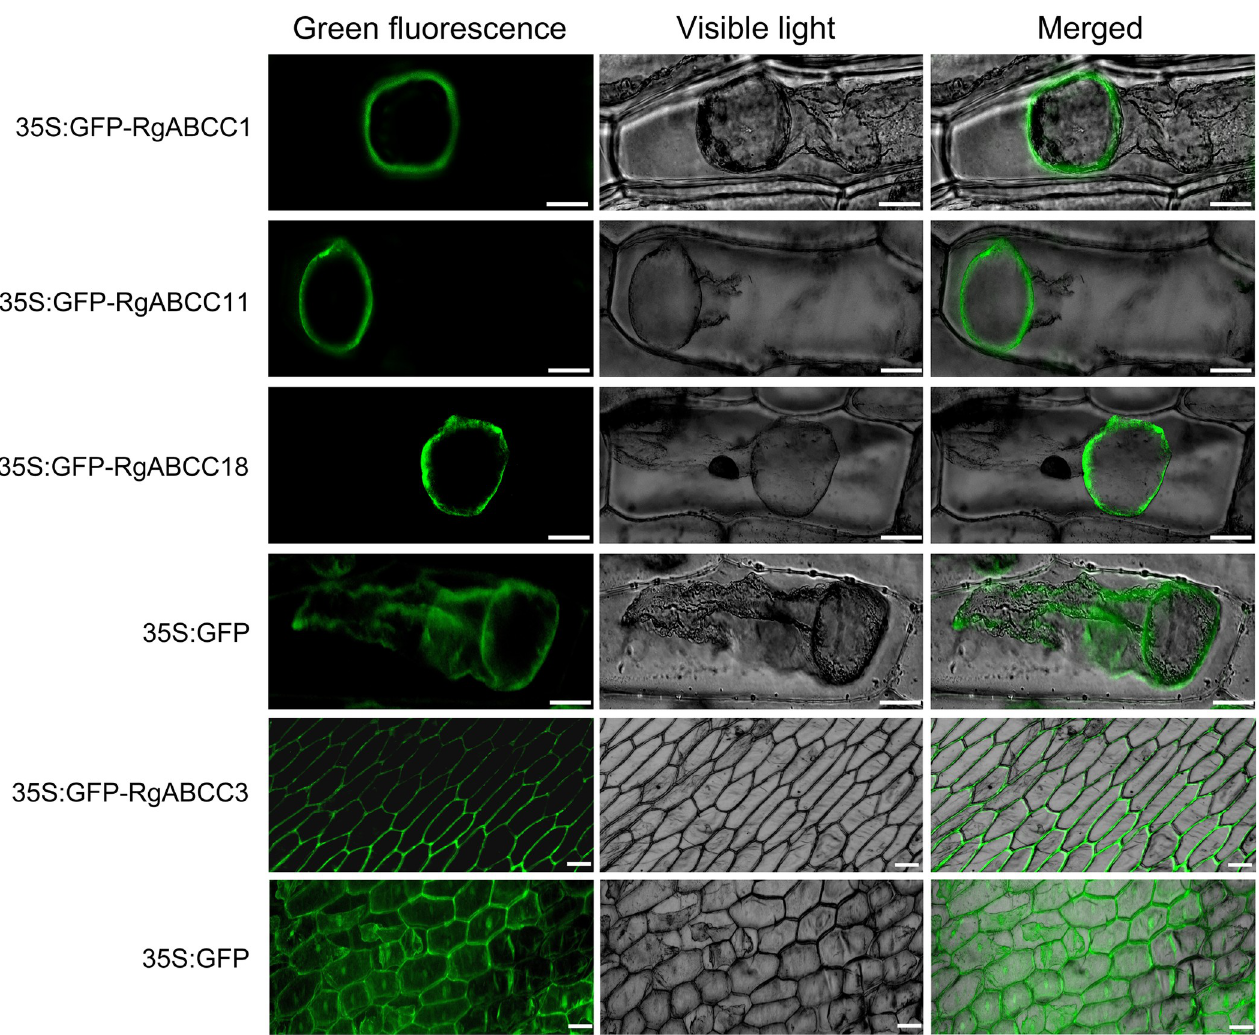
Fig 3. Subcellular localization of RgABCCs. The expression of CaMV35S:GFP-RgABCC fusion proteins in onion epidermal cells (Bars = 320 μ m).